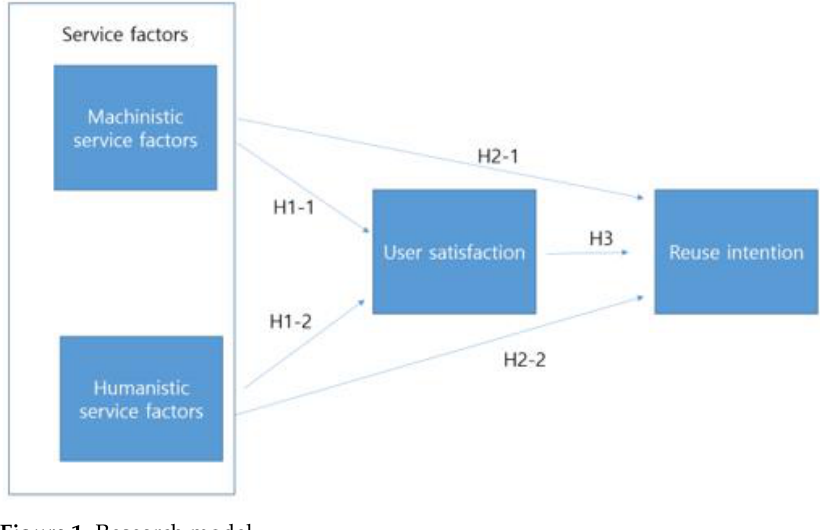
Figure 1. Research model.